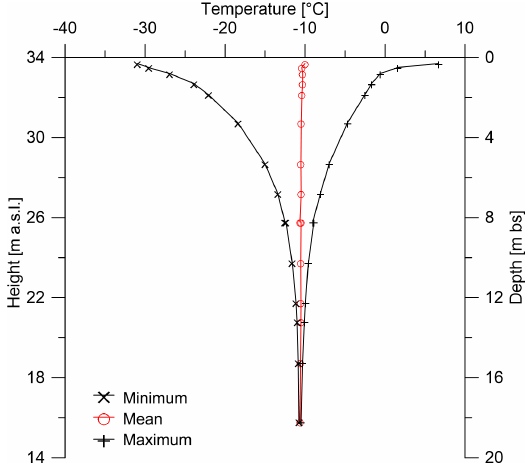
Figure 2. Minimum, mean (red), and maximum ground temper- atures based on almost 3 years (from 11 May 2012 to 27 April 2015) of measurements made at 4h intervals. Dashed lines show the approximate freezing temperature (0 ◦ C, vertical dashed line) and summer thaw depth (active layer, horizontal dashed line). Sen- sor positions are shown by symbols in height above sea level (left axis) and depth relative to ground surface (right